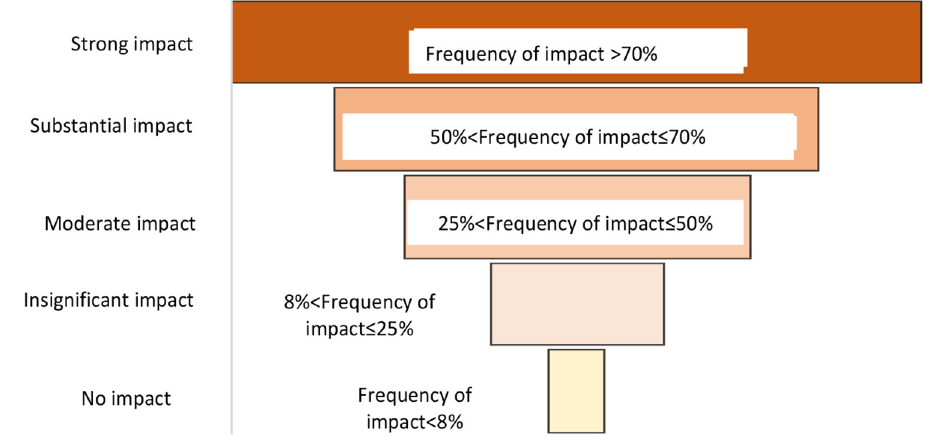
Fig. 3. Impact signi fi cance reading grid.